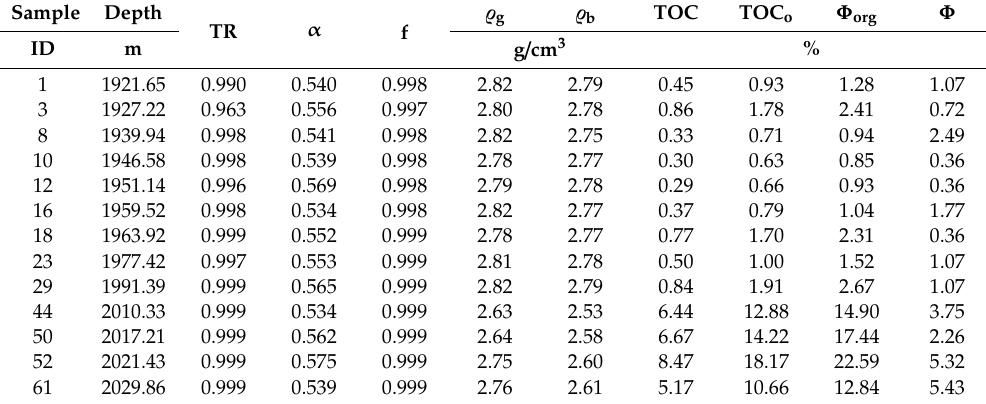
Table 5. TOC o calculation, total porosity, and organic porosity